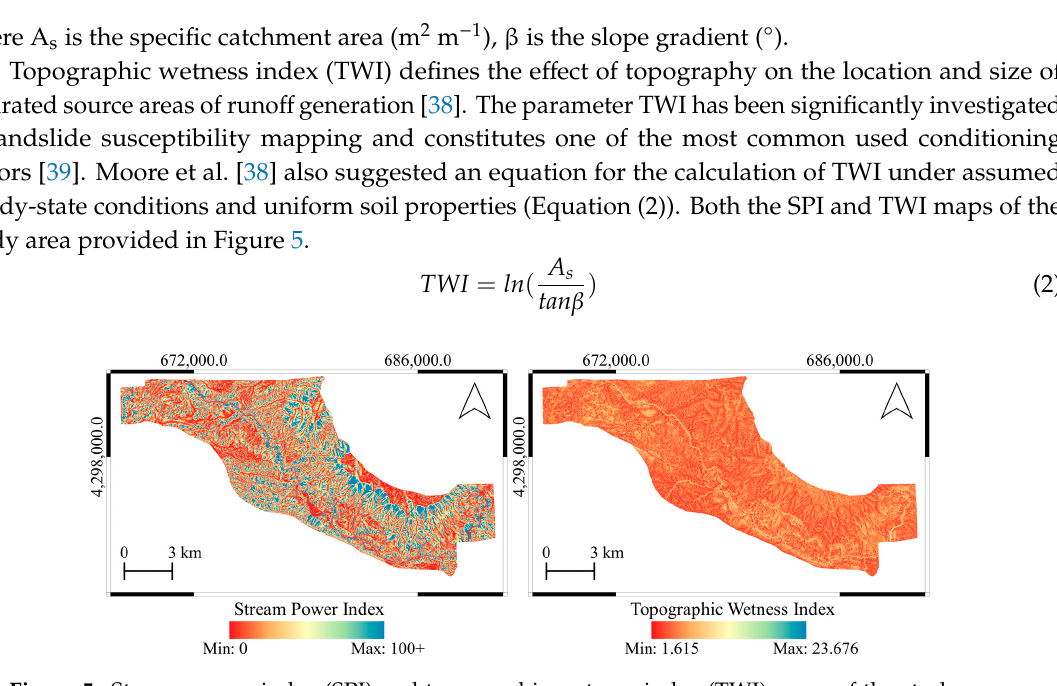
Figure 5. Stream power index (SPI) and topographic wetness index (TWI) maps of the study area produced from 2012 DTM.